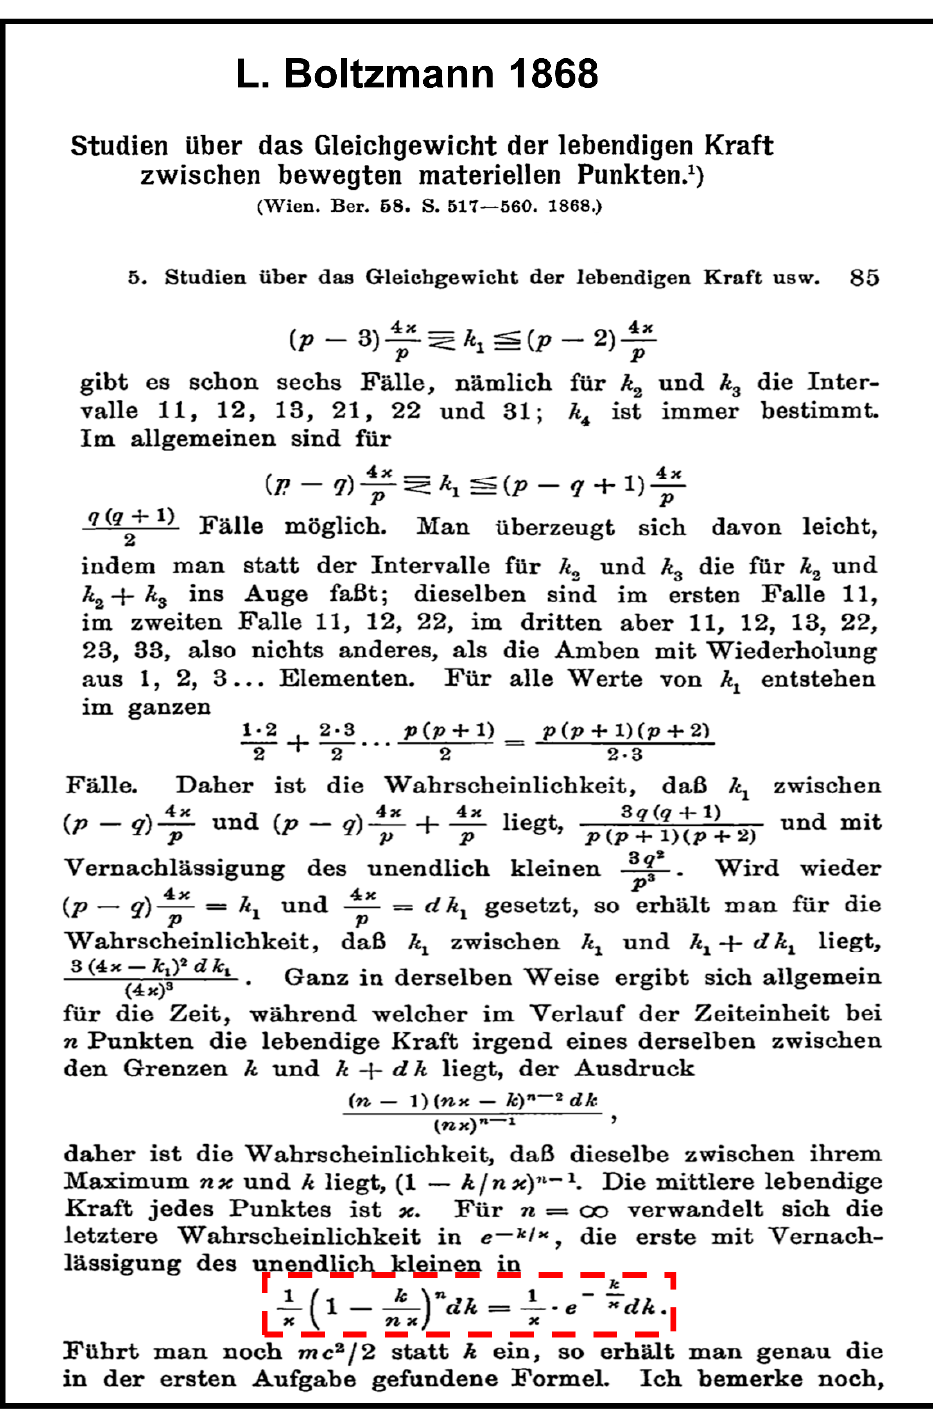
Figure 2. The page of the Boltzmann’s paper where he used a combinatorial argument that we follow in the formulation exposed in the Appendix A. He obtained the Maxwell distribution through the Euler formula (boxed) giving the exponential function as a limit of a succession.